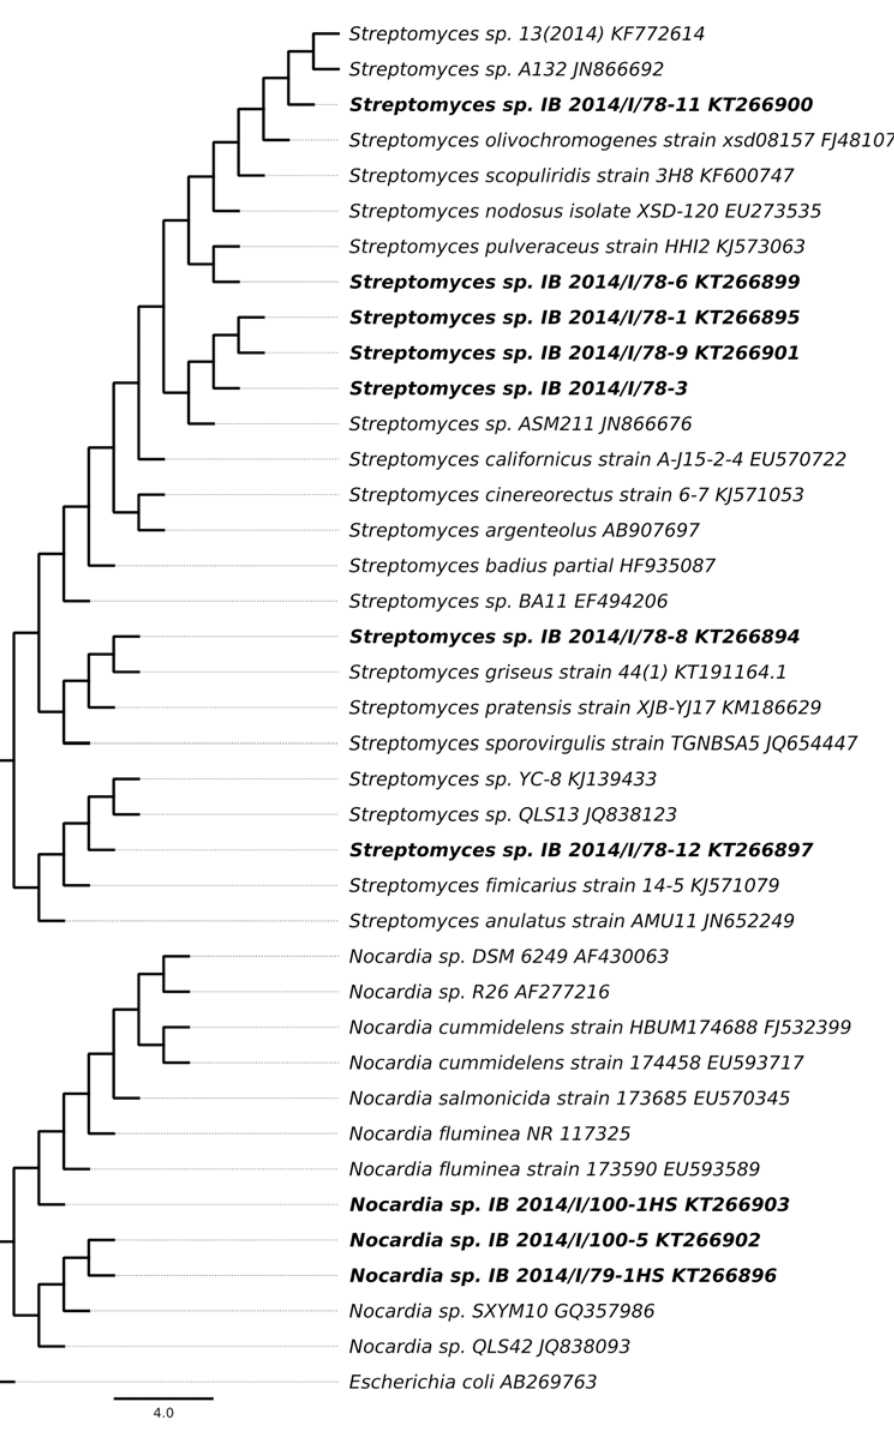
Fig 1. Phylogenetic tree of actinobacteria isolates based on the 16S rRNA gene sequences. Strain Streptomyces sp. IB 2014/I/78-8 cultivated on DNPM and strain Streptomyces sp. IB